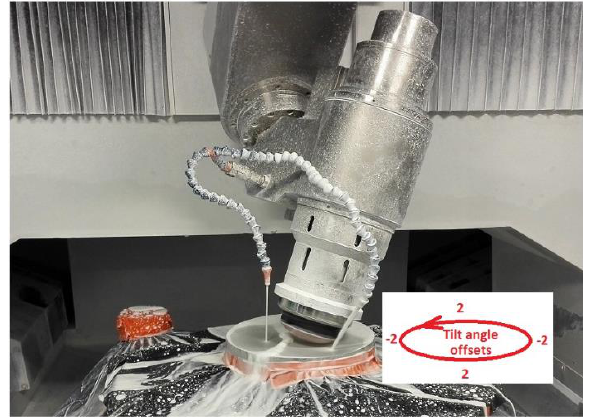
Fig. 3. Experimental setup of tilt angle.